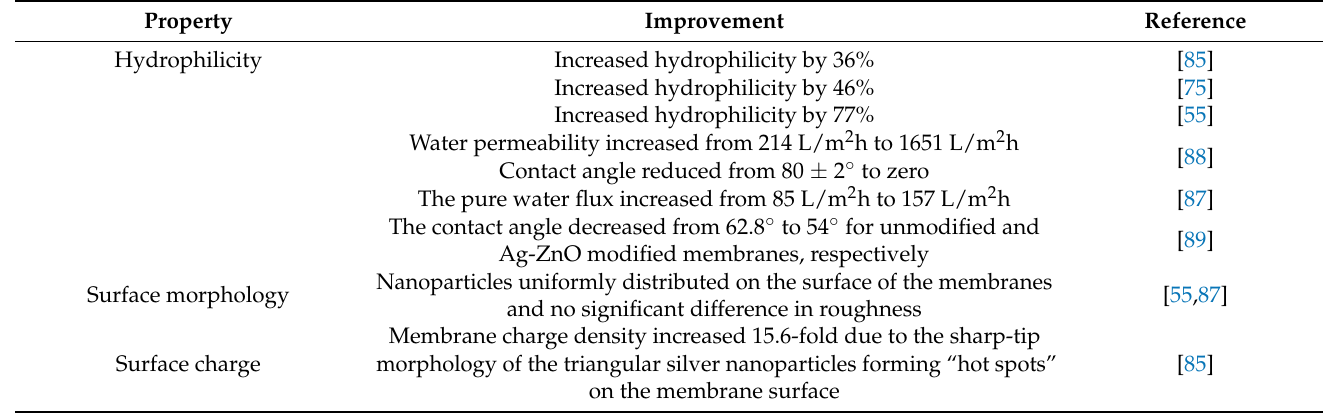
Table 2. Characterization of membranes impregnated with AgNPs.